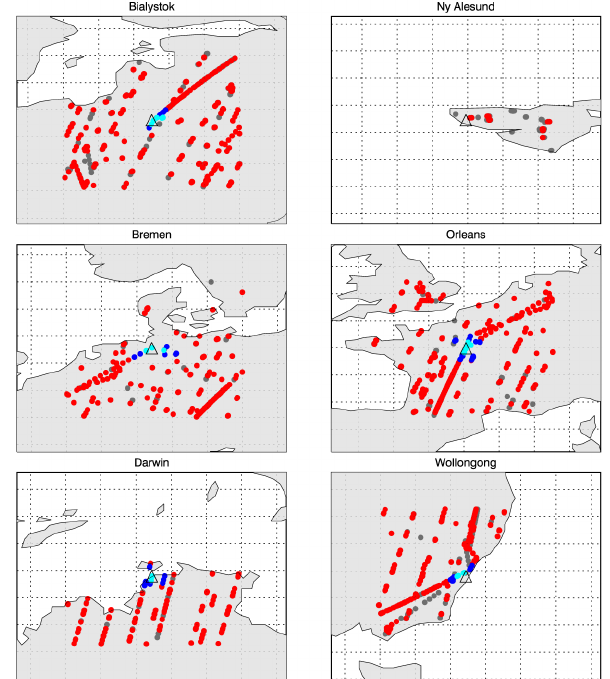
Fig. 11. Locations of GOSAT soundings over six TCCON sites be- tween April 2009 and June 2011. Grey points indicate cloud-free soundings, and red points show the quality-filtered retrievals for a spatial co-location criterion of ± 5 ◦ . Blue points are for a co- location criterion of ± 100km and cyan points for ± 50km. The tri- angle gives the location of the TCCON